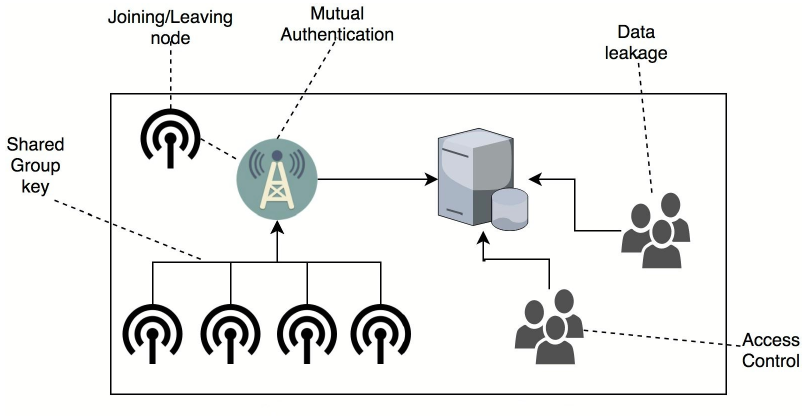
Figure 2. High level security vulnerabilities in dynamic